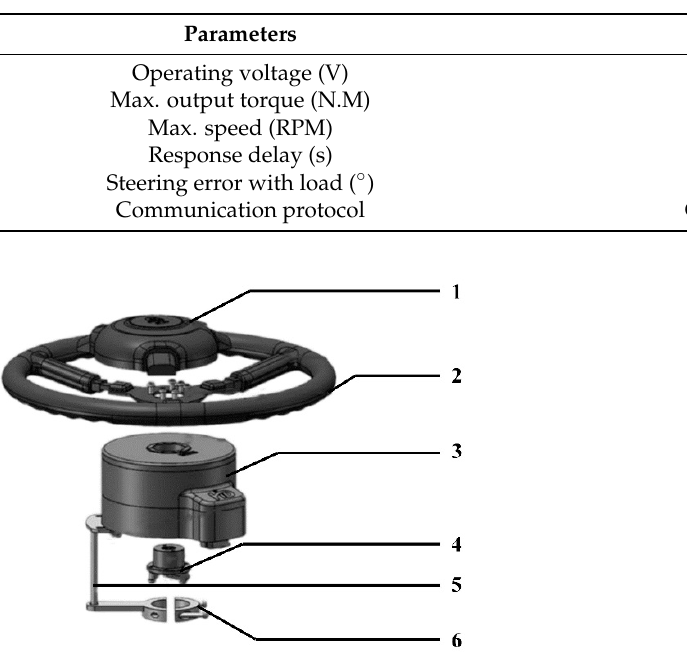
Table 2. Main parameters of electric steering wheel.